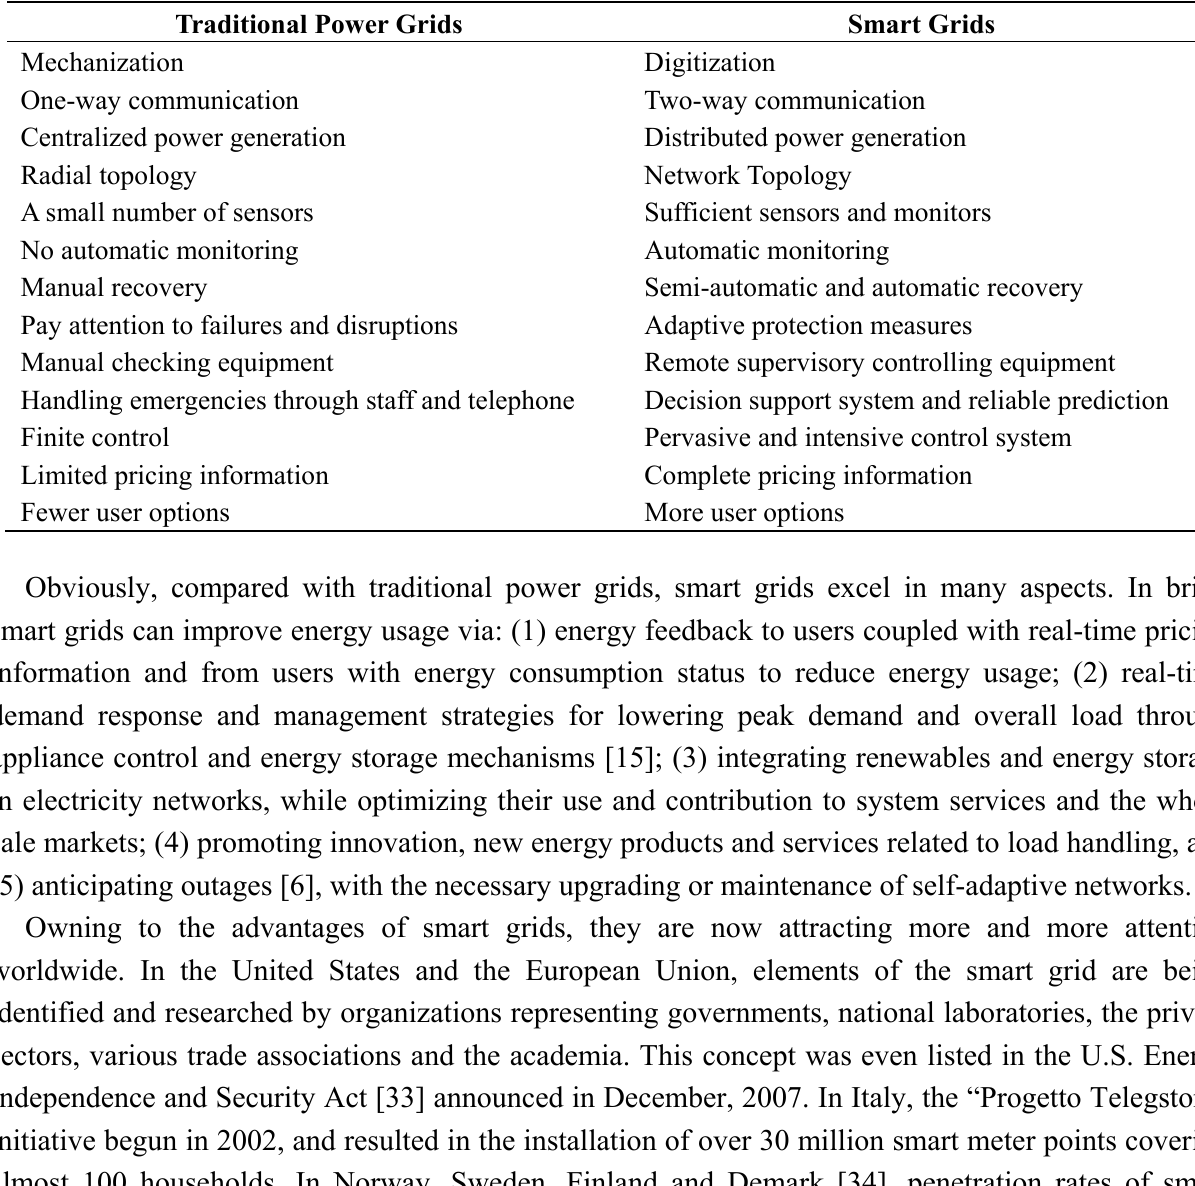
Table 1. The differences between traditional power grids and smart